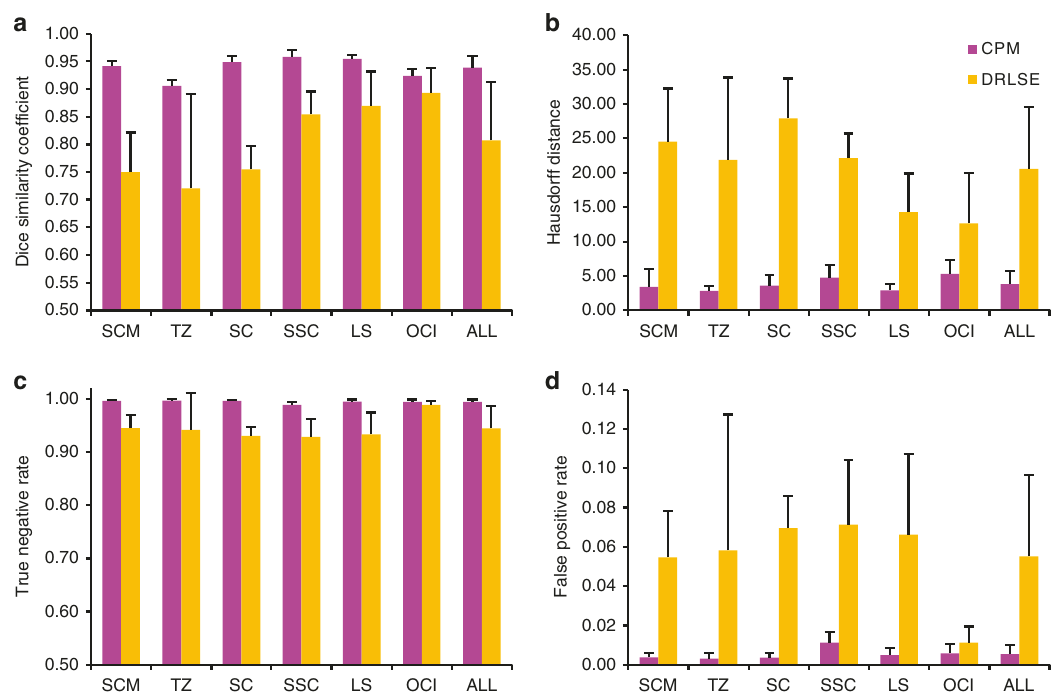
Fig. 8 Comparison of the crack-propagation method (CPM) and the level- set algorithm DRLSE. a Dice similarity coef fi cient, b Hausdorff distance, c true-negative rate, and d false positive rate. The statistical results are for muscles sternocleidomastoid (SCM), trapezius (TZ), splenius capitis (SC), semispinalis capitis (SSC), levator scapulae (LS), and obliquus capitus inferior (OCI). There are 10 images for each muscle group: fi ve are from the left region and fi ve are from the right region of the head. The last column combines all 60 images in six muscle groups. Magenta bars represent the CPM segmentation results and yellow bars represent the DRLSE. The error bars represent the standard deviation. Source data are provided in the Source Data fi